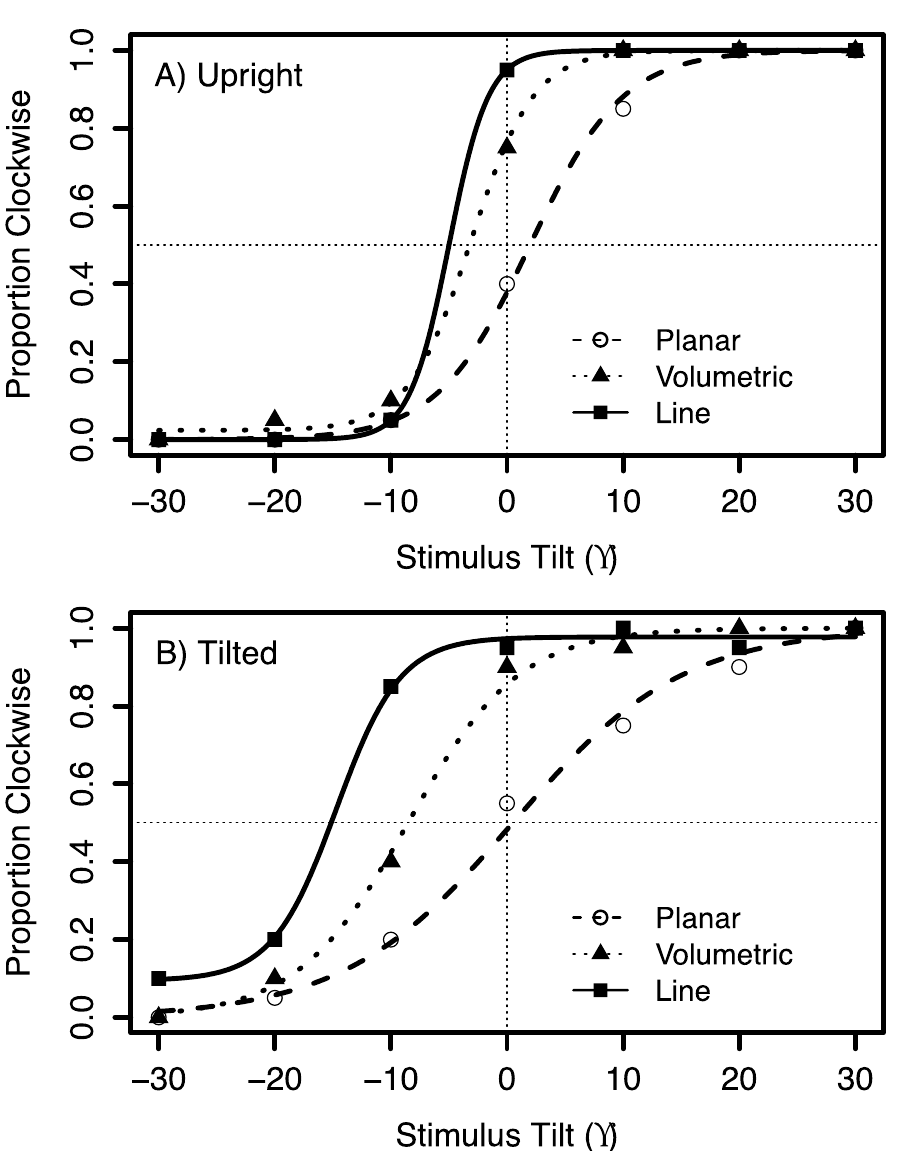
Figure 4. Psychometric functions showing the proportion of times that the stimulus was perceived as tilted in the clockwise direction relative to the gravity vector. The fitted psychometric functions from a single subject for the ( A ) “Upright” and ( B ) “Tilted” head orientations. Planar flow, volumetric flow and the line are represented by an open circle, filled triangle and filled square, respectively.